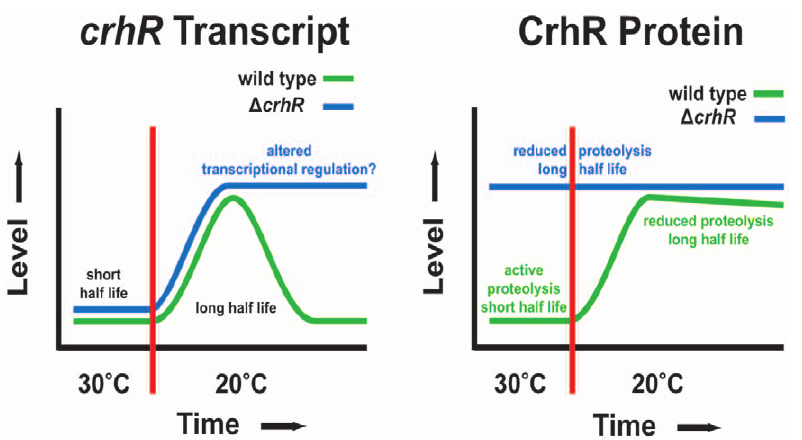
Figure 8. Schematic summary of crhR expression and regulation. crhR expression is controlled by a complex interaction between temperature-regulation of both transcript accumulation and protein degradation. crhR transcript. crhR transcript half-lives are equal and short in both wild type and D crhR Synechocystis cells which contributes to a basal level of transcript accumulation at 30 u C. A temperature downshift to 20 u C rapidly induces crhR transcript accumulation associated with enhanced half-life and with similar kinetics in both cell types, suggesting that CrhR is not required for temperature sensing or induction of its own transcript accumulation. At low temperature, crhR is transiently accumulated in wild type cells whereas conversely, transcript remains elevated at 20 u C in the D crhR mutant, suggesting that CrhR activity is required for the transient expression. Although crhR half-life is influenced by temperature, being significantly longer at 20 u C, it is identical in both cell types. This suggests that CrhR is not directly involved in degradation of its own transcript but functional CrhR is directly associated with repression of crhR transcript accumulation, most likely through another mechanism, possibly altered regulation of transcription. CrhR protein. CrhR protein levels correspond to transcript levels in wild type Synechocystis , accumulating to a basal level at 30 u C and increasing significantly at 20 u C. This is distinctly not the case in the D crhR mutant in which CrhR protein remains elevated and constant at both temperatures. CrhR protein accumulates to the level observed in wild type Synechocystis at 20 u C, irrespective of transcript accumulation or temperature. Combined, these results suggest that the reduced level of CrhR at 30 u C is caused by proteolytic degradation which is temperature- and CrhR-dependent as this process is inactive in the D crhR mutant. In addition, there appears to be a maximal level of CrhR that can accumulate in cells, irrespective of the transcript level, a process that is CrhR independent. This accumulation appears to be a default level as it was never observed to increase above the level detected in wild type cells at 20 u C.